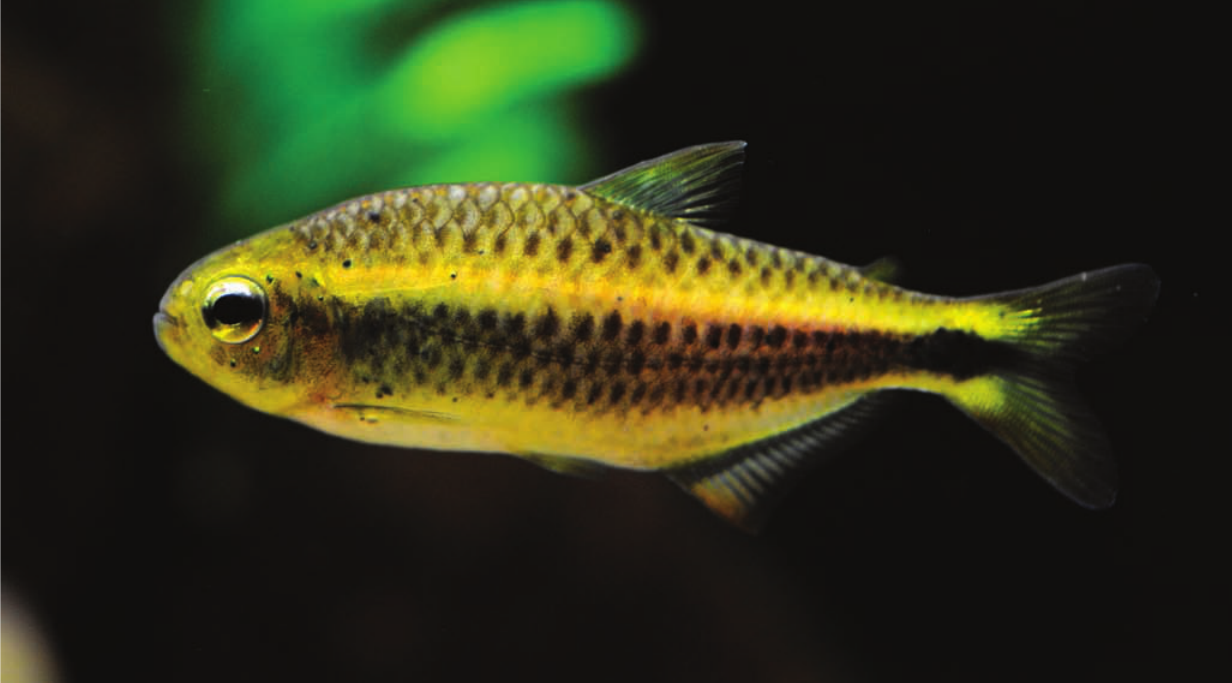
Fig. 7. Moenkhausia plumbea , aquarium specimen showing live coloration from Brazil, Pará, Novo Progresso, tributary of rio Braço Norte, rio Tapajós basin, collected with MZUSP